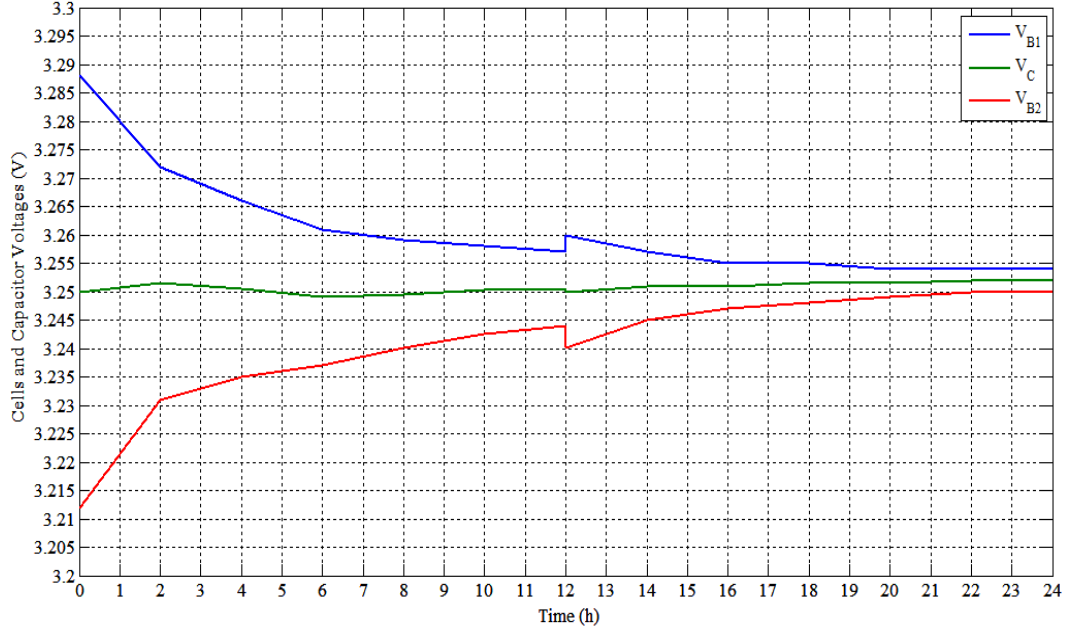
Figure 27. Experimental results of 2.3 A·h cells with SSC balancing (Test No.